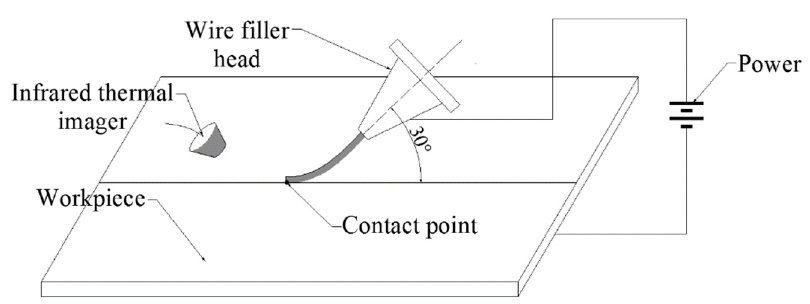
Figure 1. Schematic diagram of wire temperature measuring.